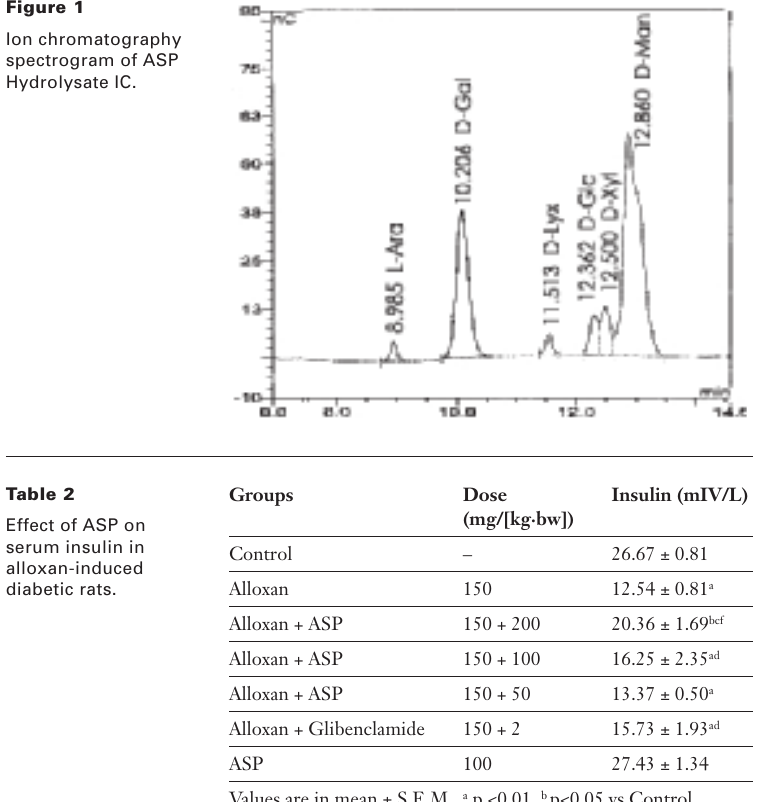
Ion chromatography spectrogram of ASP Hydrolysate IC.